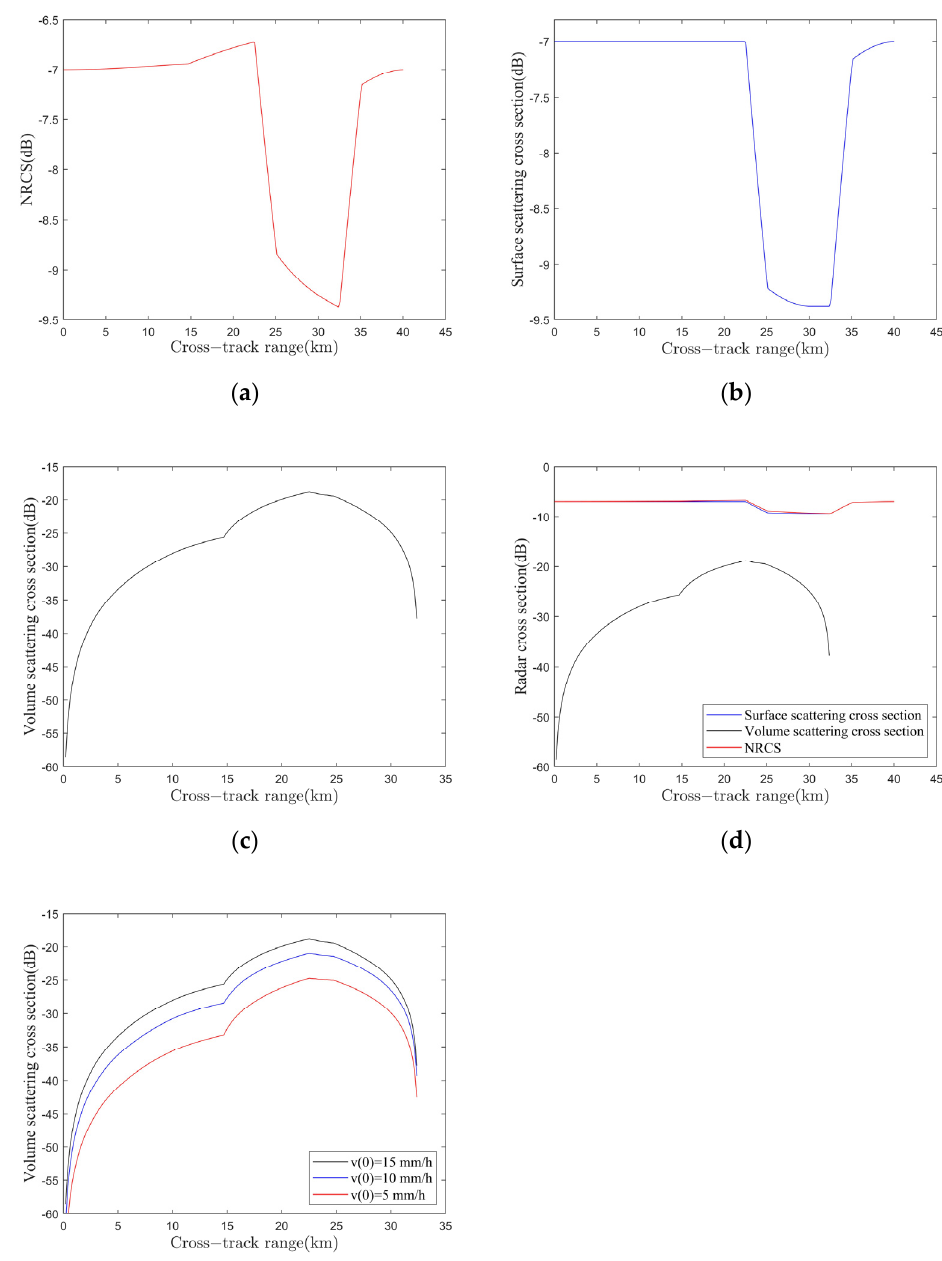
Figure 4. Simulation of NRCS in moderate rain. ( a ) The normalized radar cross section of 𝑣(0) = 15 mm/h; ( b ) the surface scattering cross section of 𝑣(0) = 15 mm/h; ( c ) the volume scattering cross section of 𝑣(0) = 15 mm/h; ( d ) components of normalized radar cross section of 𝑣(0) = 15 mm/h and ( e ) comparison of the volume scattering cross section of 𝑣(0) = 15 mm/h, 10 mm/h, and 5 mm/h.